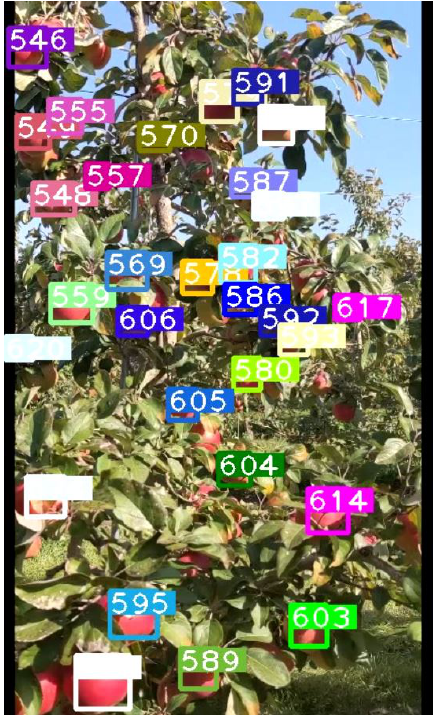
Figure 9. A frame taken from the video of the apple tree during runtime, just in this frame there are approximately 30 apples being tracked, in addition to the saved tracks that are not currently detected. There are several apples that are largely occluded for which one of the following scenarios could be true: (1) previously detected and counted before becoming obscured; (2) will be detected next with the camera motion or with a clearer angle; (3) will fail to be detected leading to a loss in counting accuracy.